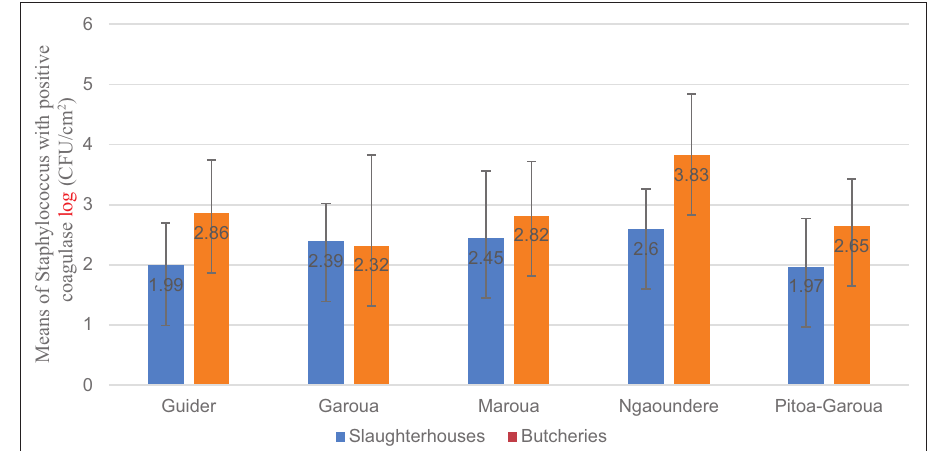
Figure-1: Distribution of the average loads of Staphylococcus with positive Table-5: Resistance to Staphylococcus with positive coagulase. Slaughterhouses